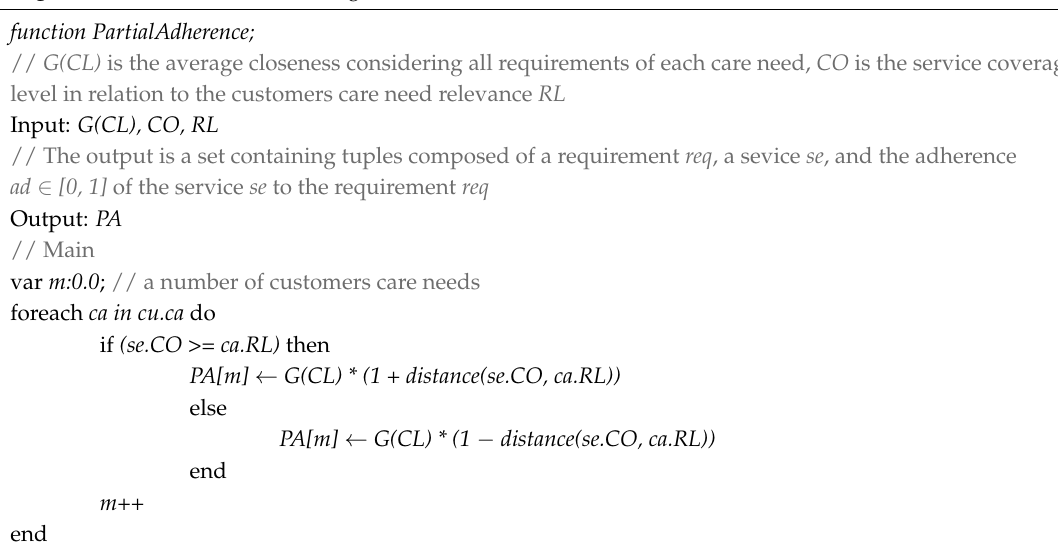
Algorithm 3 Partial Adherence Algorithm